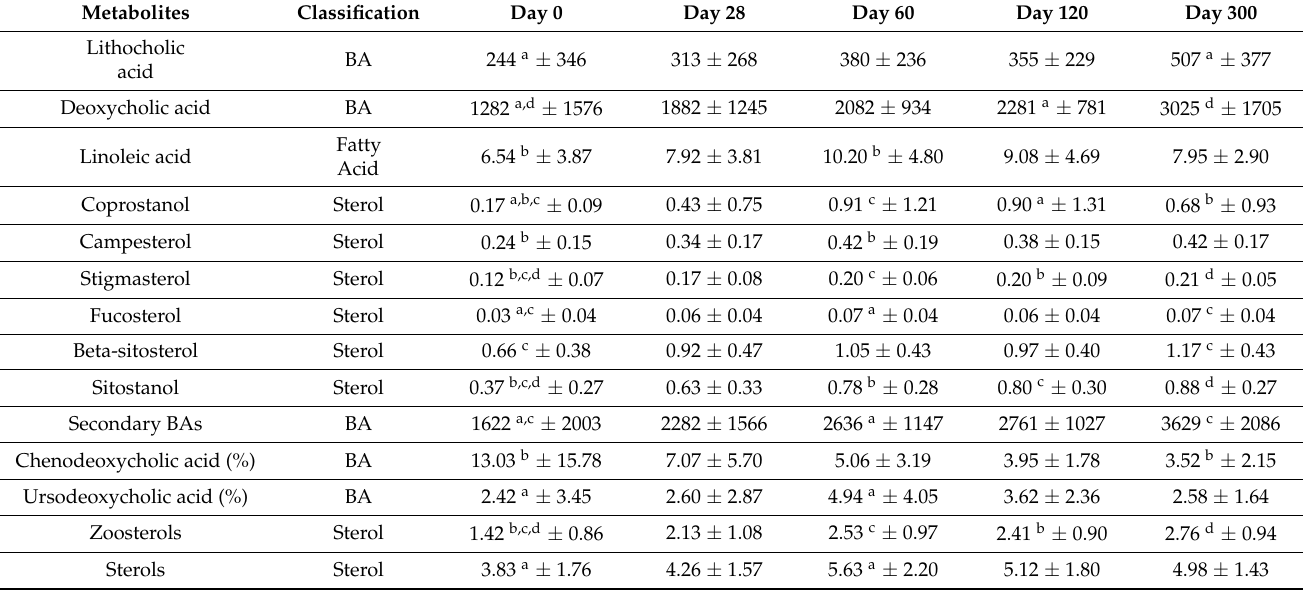
Table 5. Concentrations of fecal metabolites that significantly differed over time within CON cats.